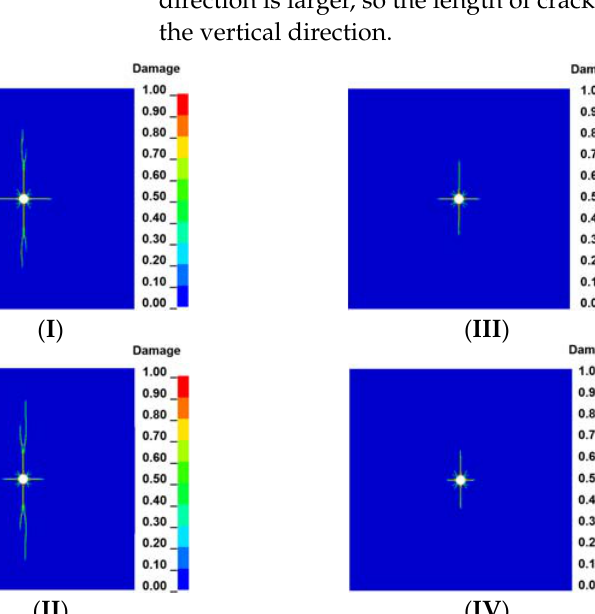
Figure 11. Crack length under different in ‐ situ stresses.